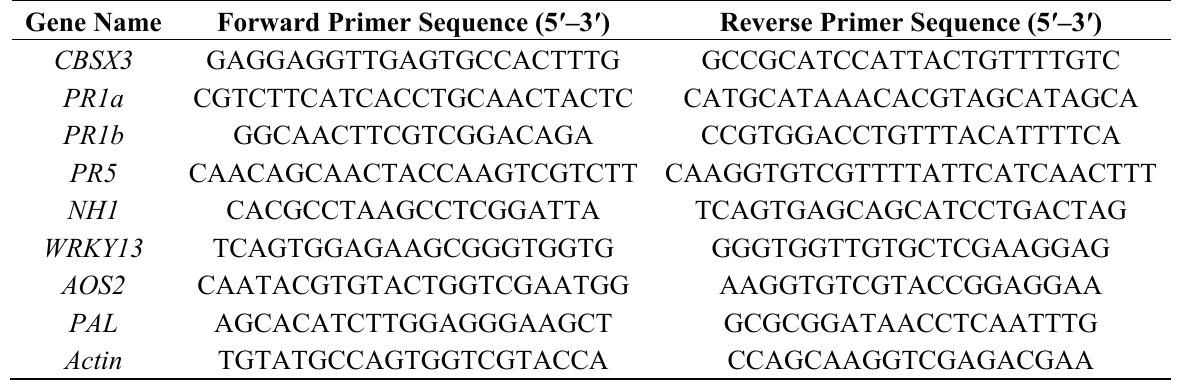
Table 1. Primers information for real-time